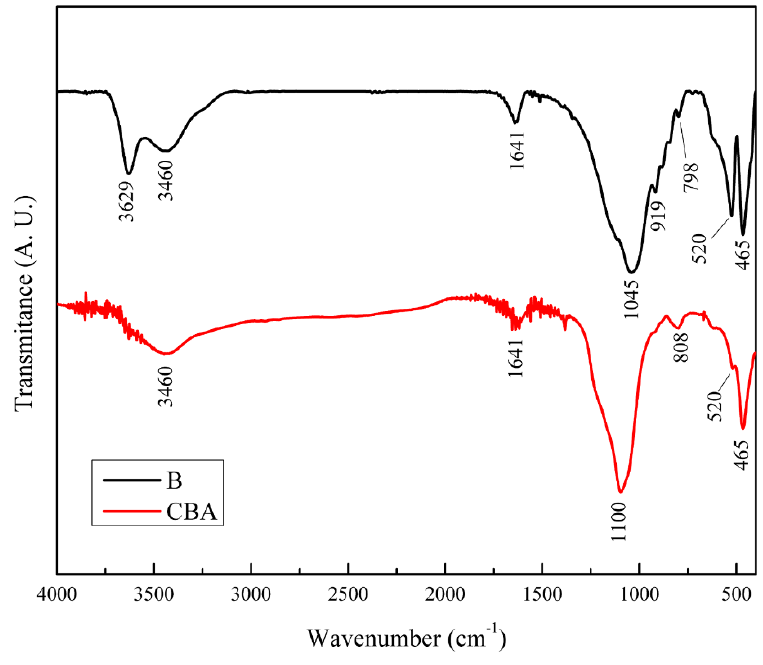
Figure 2. FTIR spectra of solids B, CB, and CBA.